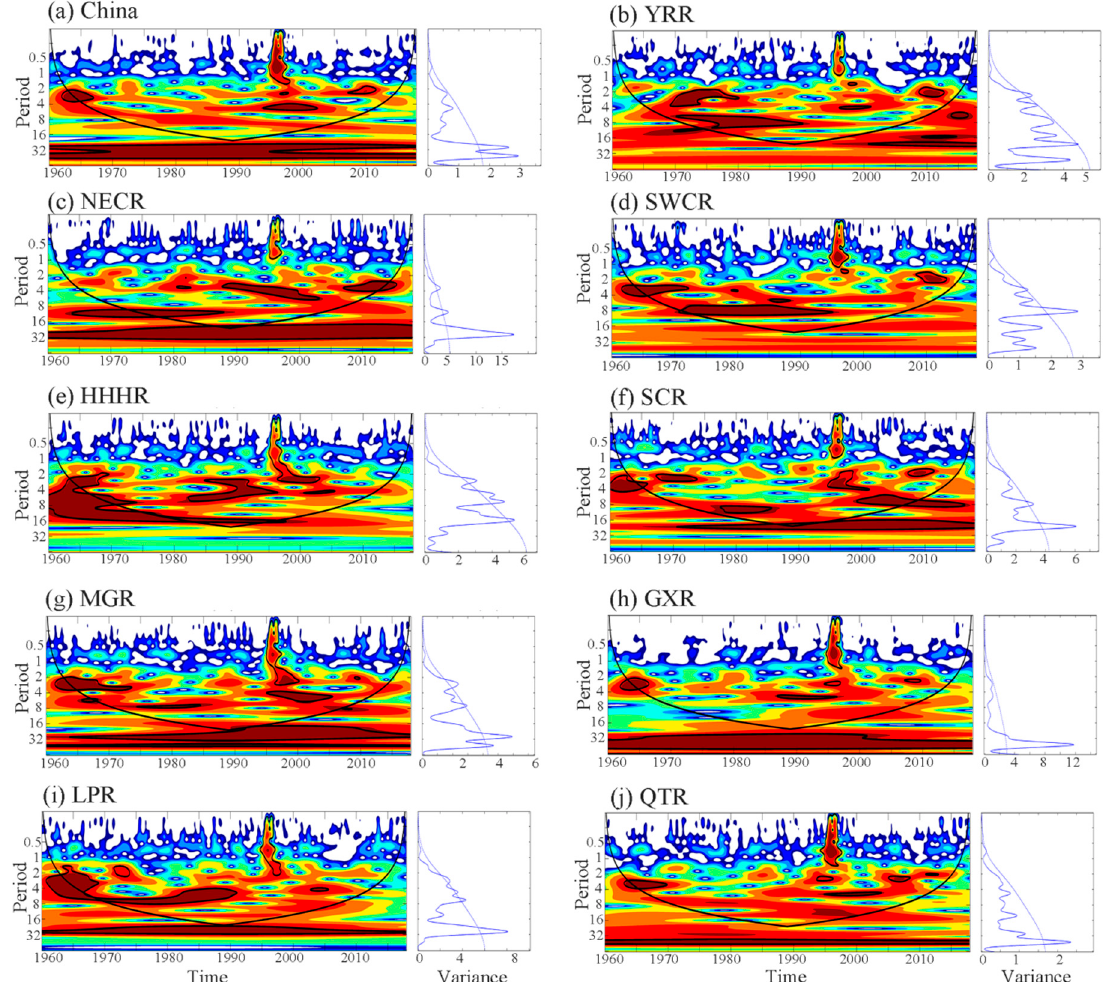
Figure 5. Wavelet analysis map of SPEI_pm in nine major Chinese agricultural regions. ( a ) represents the Chinese mainland. ( b – j ) represent the YRR, NECR, SWCR, HHHR, SCR, MGR, GXR, LPR, and QTR, respectively. Figures on the left are wavelet power spectra; those on the right are the global wavelet power spectra. They are color-mapped to indicate high wavelet power with orange and low power in blue and white. The thick black contour in the left section designates the 95% confidence level against red noise, and the cone of influence (COI) where edge effects might distort the picture is shown in a lighter shade. The imaginary line in the right section designates the 95% confidence level for a red noise null hypothesis. If the peak of the solid line is above the imaginary line in the power map, then the corresponding period is significant.